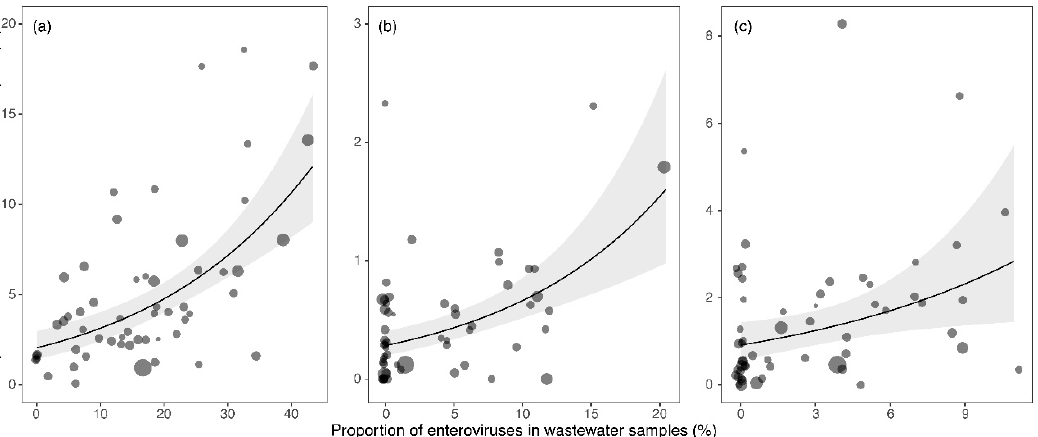
Figure 4. Relationships between the proportion of all enteroviruses ( a ), coxsackieviruses B (CVB) ( b ), and Echoviruses (E) ( c ) in wastewater versus clinical samples. GLM-based estimates (lines) are displayed along with 95% confidence intervals (gray bands) and observed values (points). Point size is proportional to the number of samples taken in the given year. Note that the position of samples is slightly jittered to avoid overlap. The x axis shows the proportion of enteroviruses in the wastewater sample in percentages, and the y axis show the proportion of enteroviruses in clinical